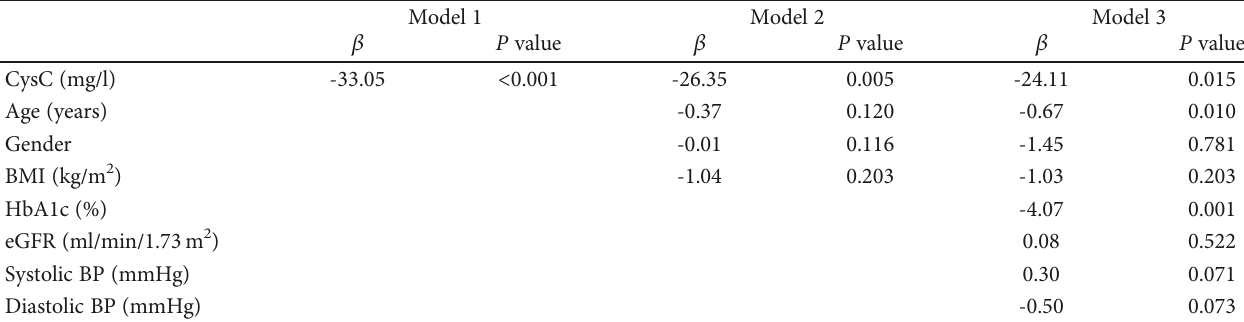
Table 4: Linear regression analysis of SDNN with di ff erent clinical characteristics.